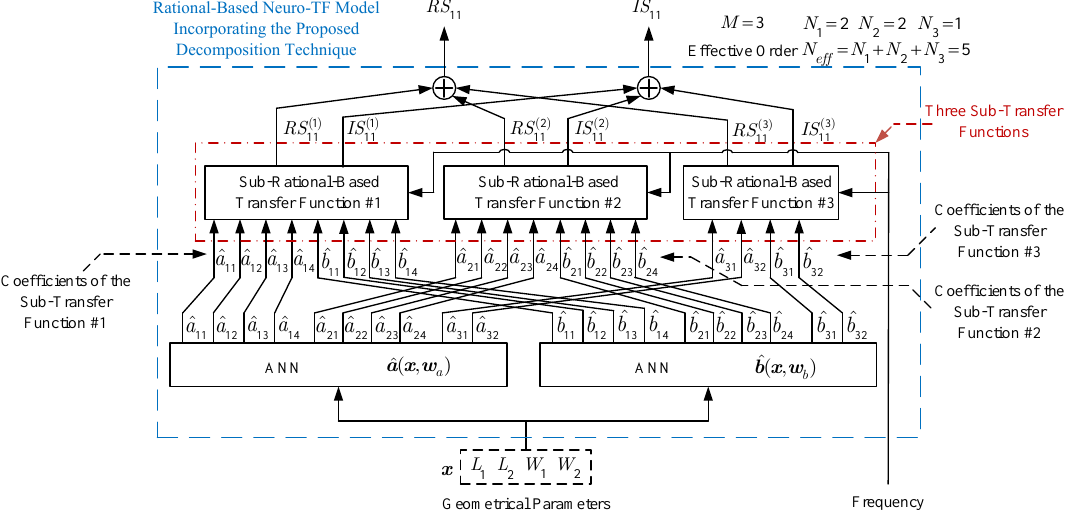
Figure 4. Structure for the proposed rational-based neuro-TF model with M = 3 of the three-order waveguide filter